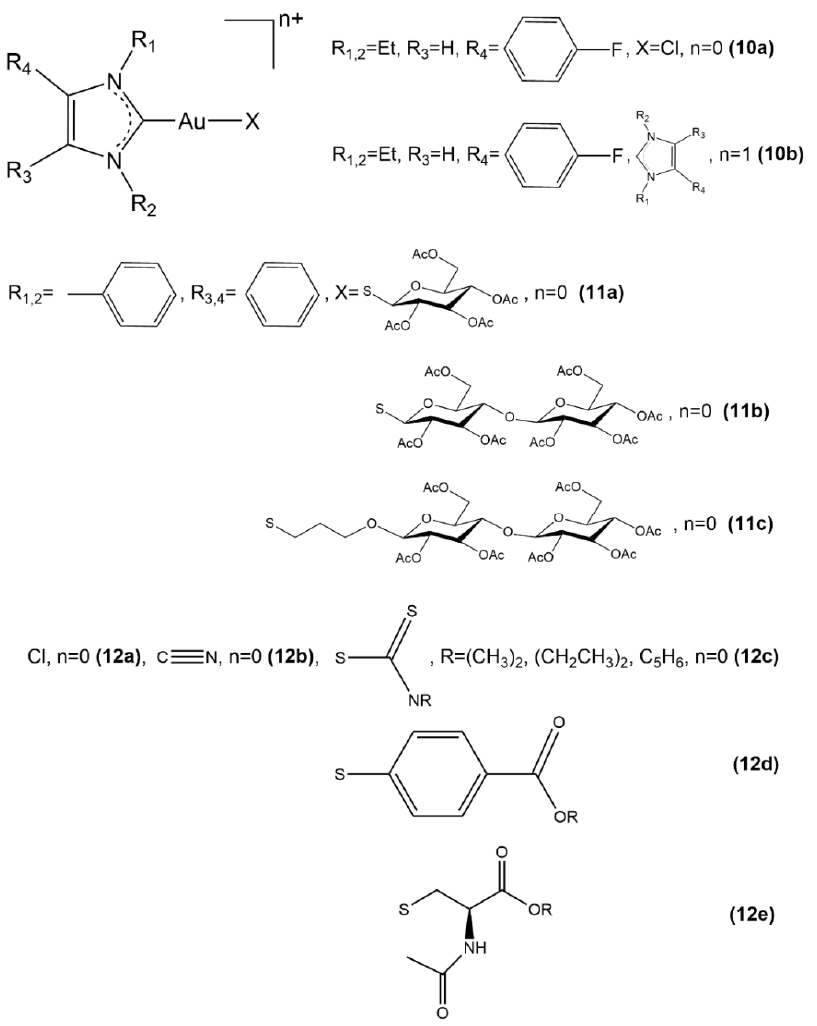
Figure 7. Gold(I) complexes with NHC carbenes ( 10a – 10b , 11a – 11c , 12a – 12e ).